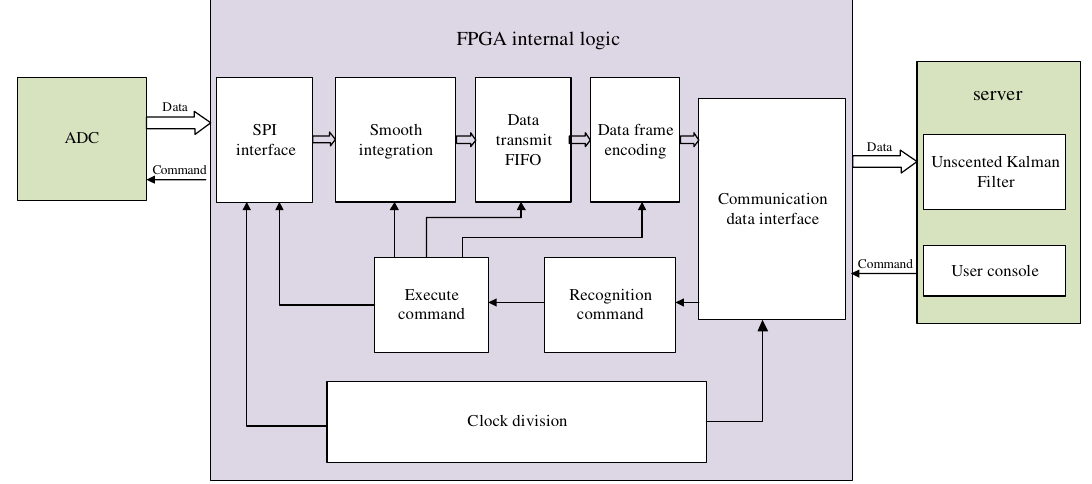
Figure 5. Monitoring system software design block diagram.